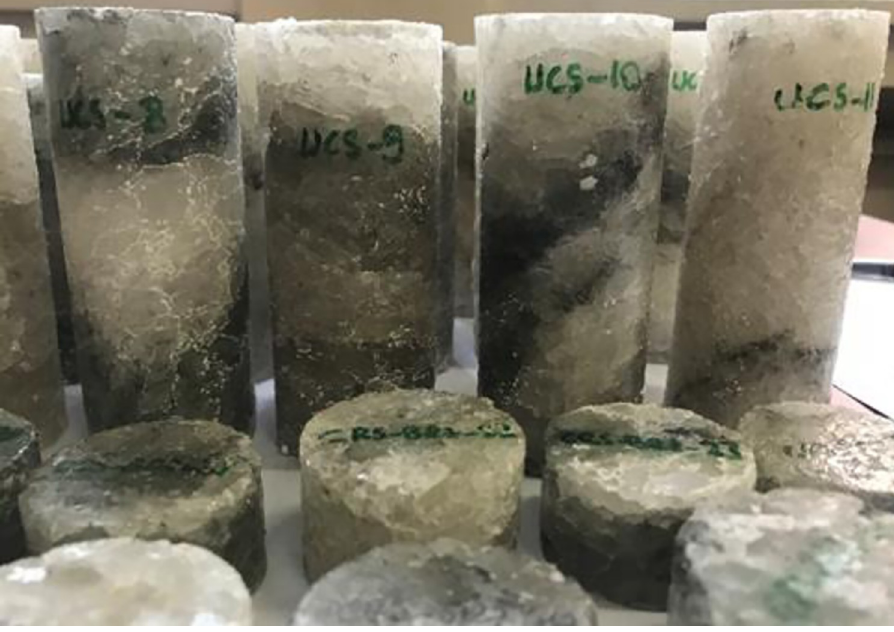
Fig 3. Some rock salt core samples prepared for uniaxial compression and Brazilian tensile tests.